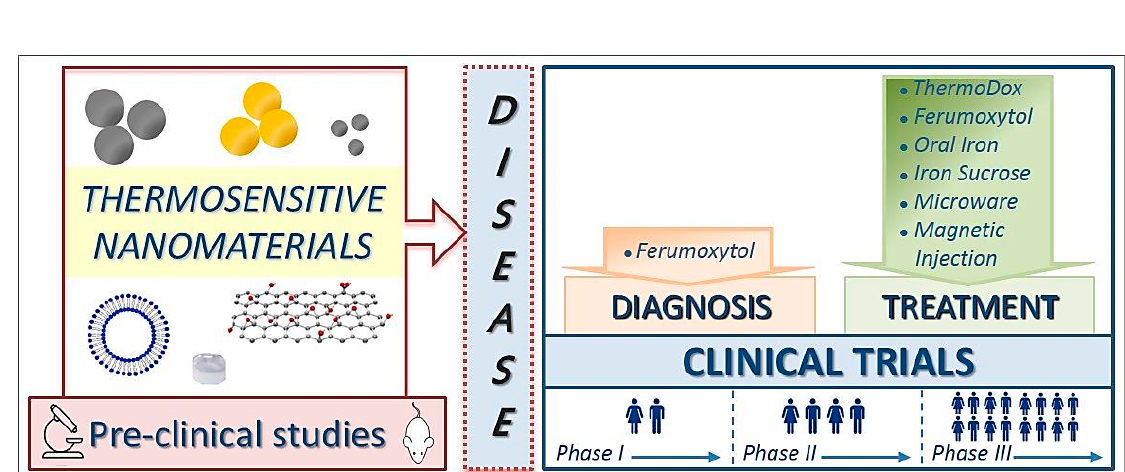
Figure 1. Illustration of the uses of thermosensitive nanomaterials.